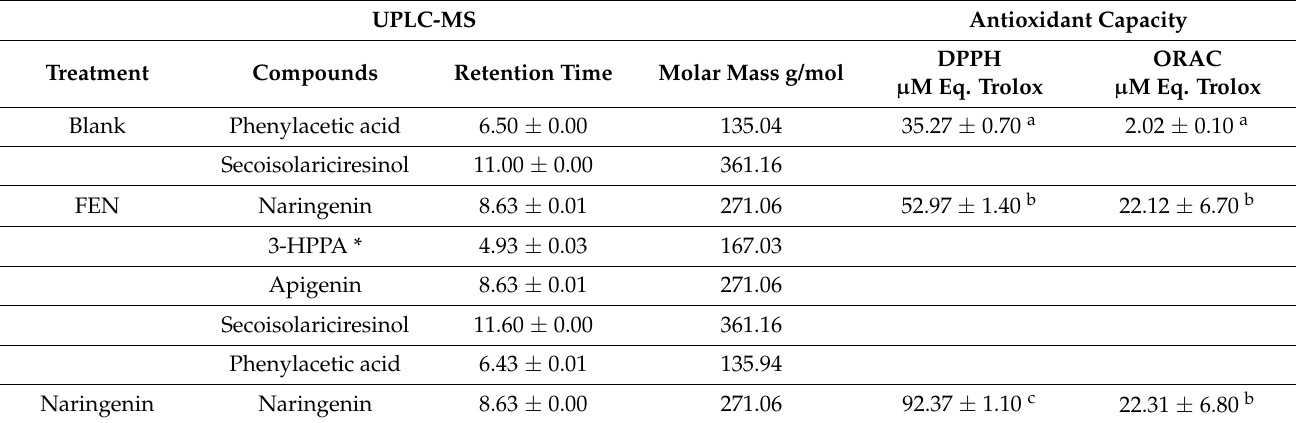
Table 1. Identification of FEN compounds and Naringenin by UPLC-MS and their antioxidant capacity.